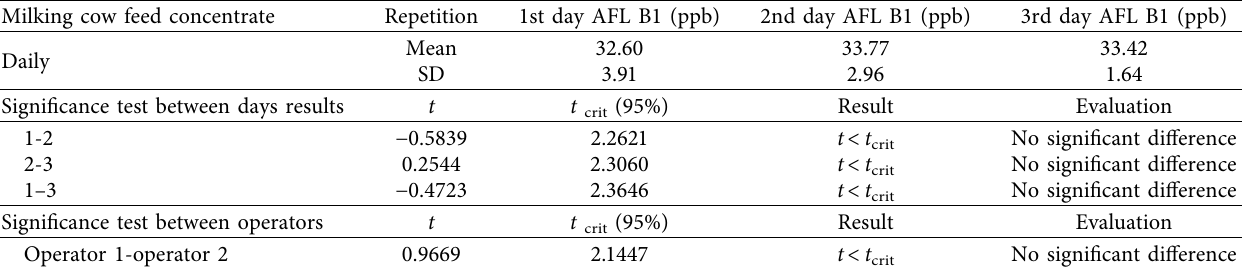
Table 6: Repeatability of the ELISA method for milking cow feed concentrate. Two operators measured AFL B1 in three repetitions on three different days from freshly prepared samples. SD, standard deviation. Spike: 40 ppb AFL